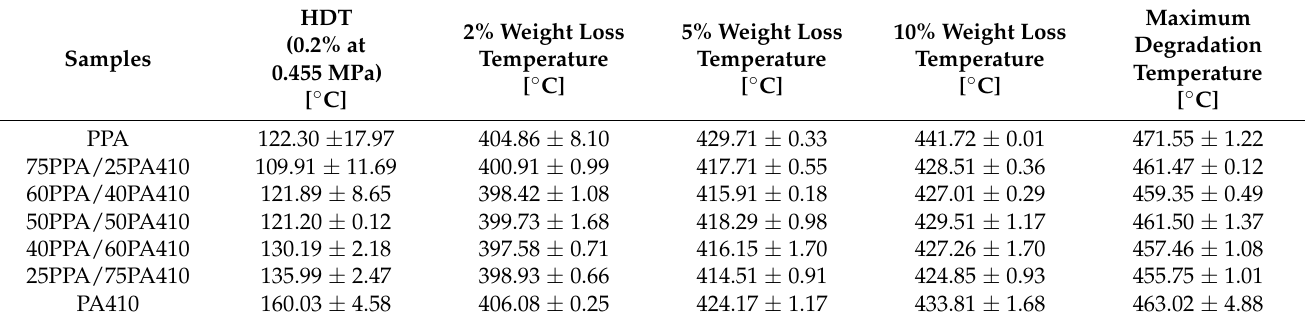
Table 3. Thermal properties derived from the TGA and HDT analysis of the produced PPA/PA410 blends.